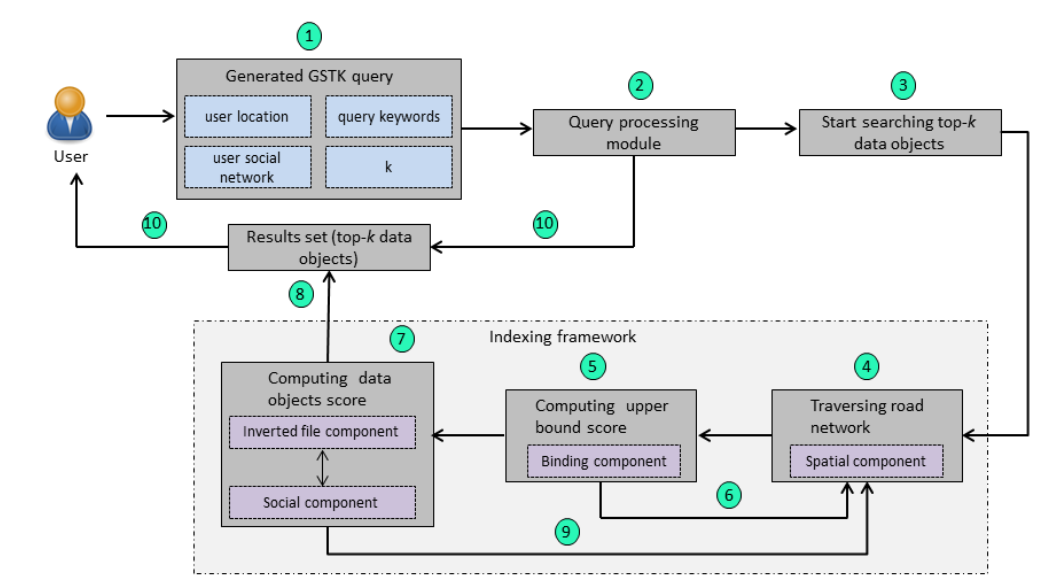
Figure 5. Overview of the proposed query processing